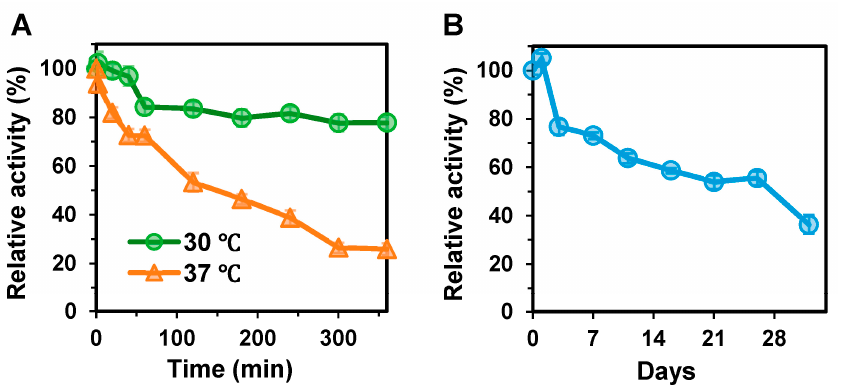
Figure 4. The stability of the recombinant heparinase I. ( A ) The thermostability of BxHep-I at 30 and 37 °C and ( B ) the storage stability at 4